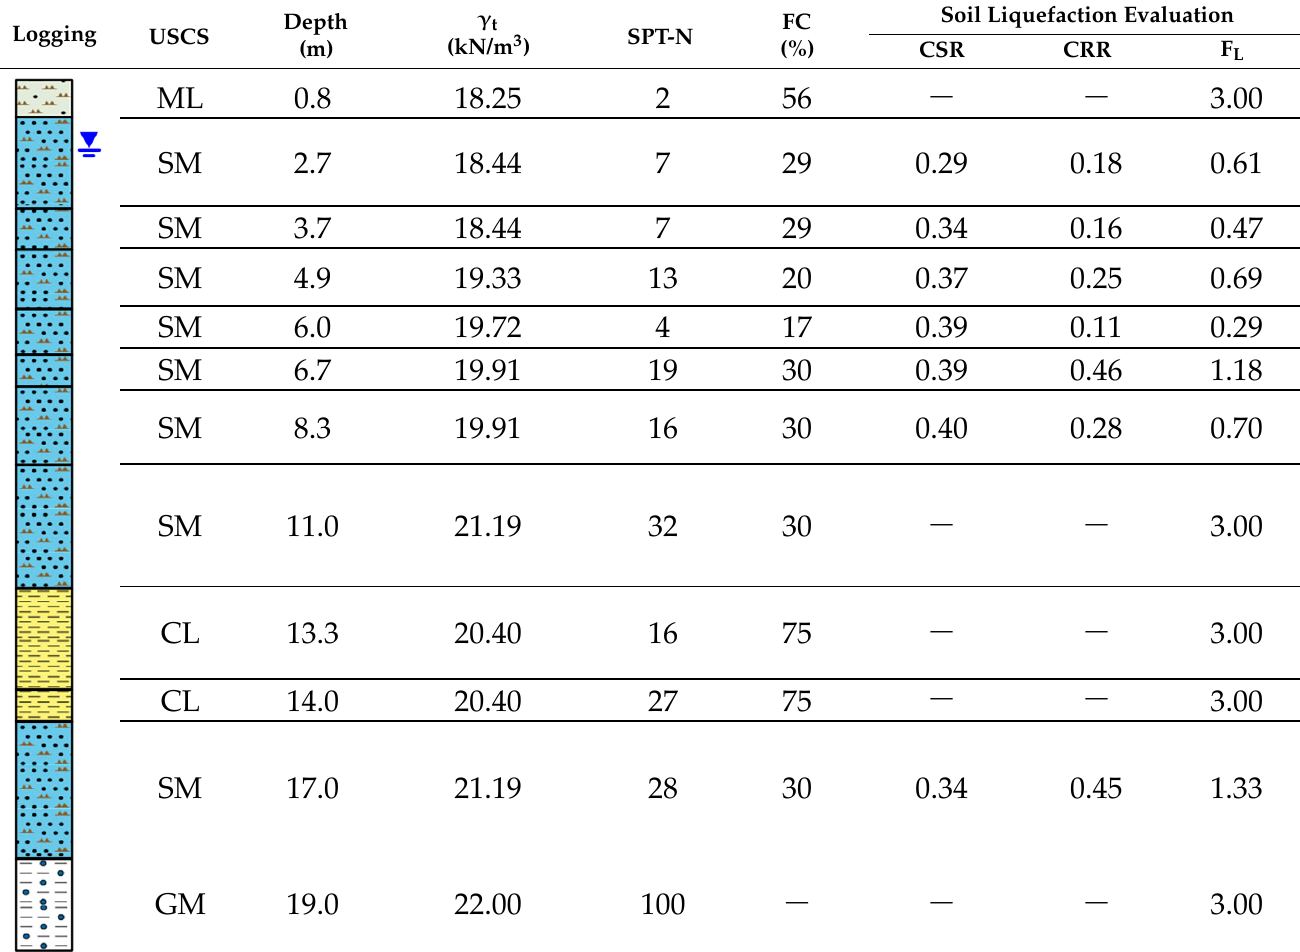
Table 5. The information of the reference borehole.